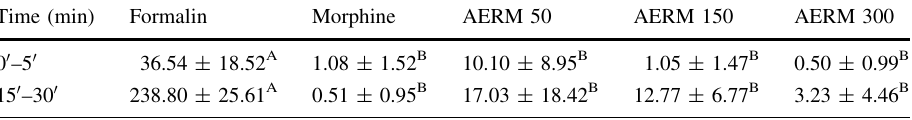
Table 3 Analgesic effect by formalin test of AERM (50, 150 and 300 l g kg - 1 )